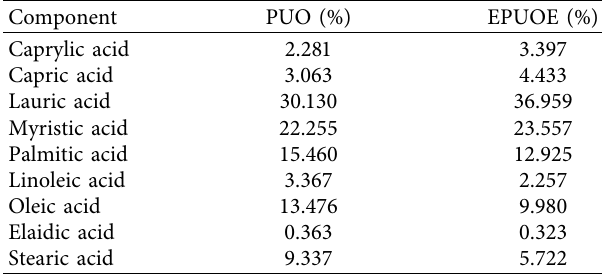
Table 1: Fatty acid analysis of PUO and EPUOE by GC-MS.